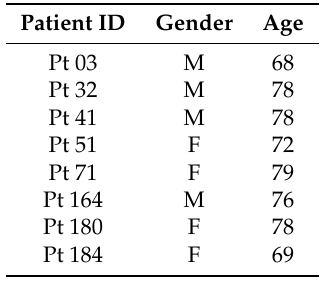
Table 1. Demographic data of the recruited